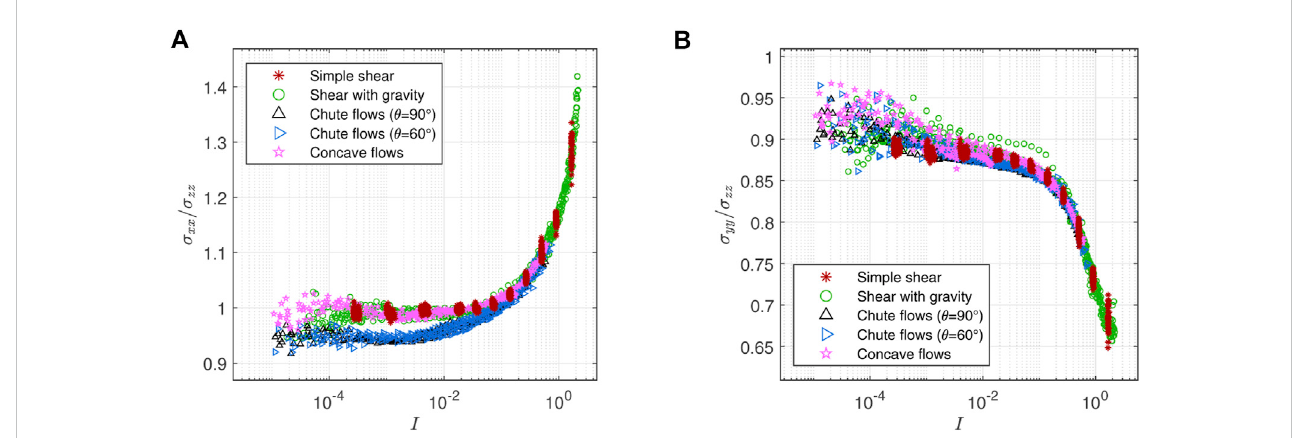
FIGURE 3 Normalstressratiosinplanarsheartests: (A) σ xx / σ zz isnear1for I < 0.1andincreasesrapidlyas I increases for I > 0.1. (B) σ yy / σ zz isspreadbetween0.85and 0.95 for I < 0.1 and becomes even smaller as I increases for I >